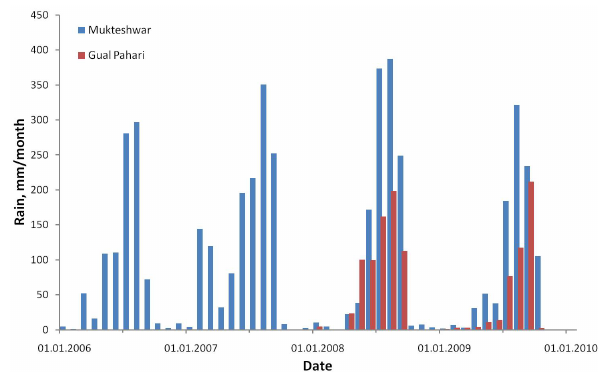
Fig. 2. Monthly rain accumulation during the running of the mea- surement